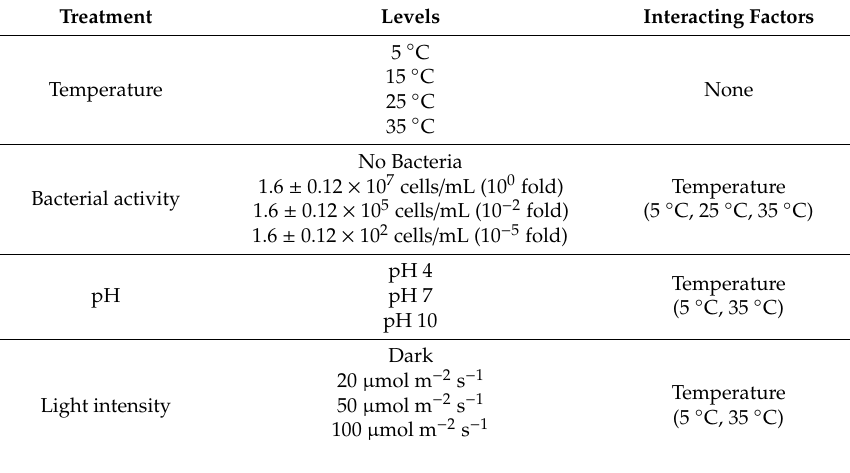
Table 1. The summary of the treatments and their interacting factors. Other treatments than light intensity were conducted in the dark and all treatments were run separately in triplicate over the 4